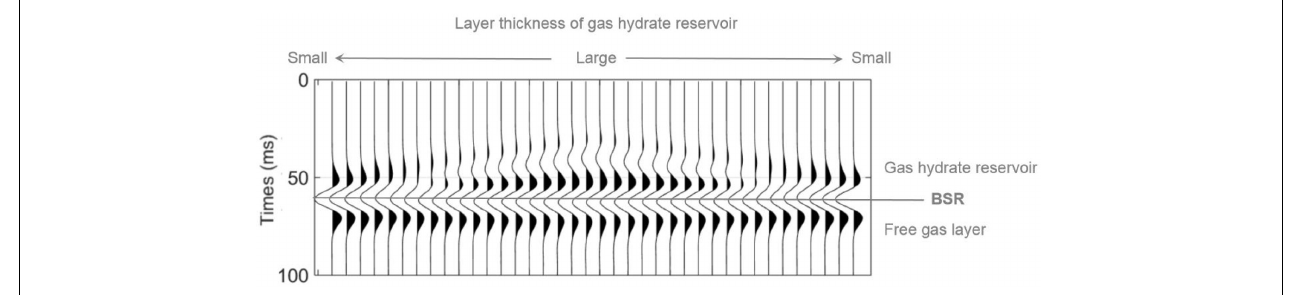
FIGURE 14 | The post-stacked seismic responses of the model in Figure 13 .